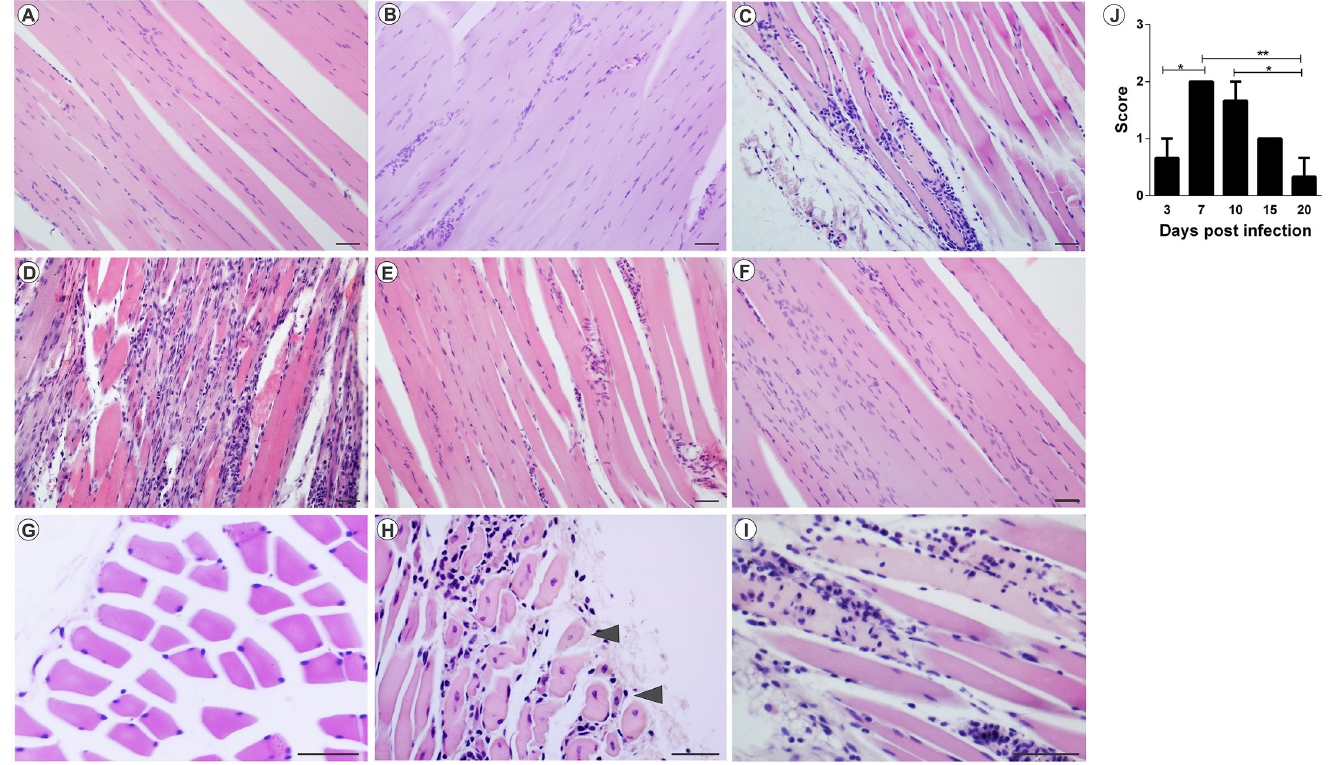
Fig 6. Myositis Mayaro virus-induced contralateral muscle in mice infected below the right forelimb with 1.25x10 7 PFU. The animals were sacrificed on days 3, 7, 10, 15 and 20 PI. for tissue damage analysis. The quadricep muscles were fixed in Karnovsky, embedded in paraffin, and 5 μ m sections were made and stained with HE. (A) Negative control. (B) MAYV infection at 3 days PI. (C) MAYV infection at 7 days PI. (D) MAYV infection at 10 days PI. (E) MAYV infection at 15 days PI. (F) MAYV infection at 20 days PI. (G) Negative control, fibers in cross-section. (H) Fibers in cross section showing centralized nuclei (arrowhead). (I) Fibers undergoing phagocytosis. (J) Histological score. Images A, B, C, D, E, F (200X magnification), G, H and I images (400X magnification). 40 μ m bar. N = 3